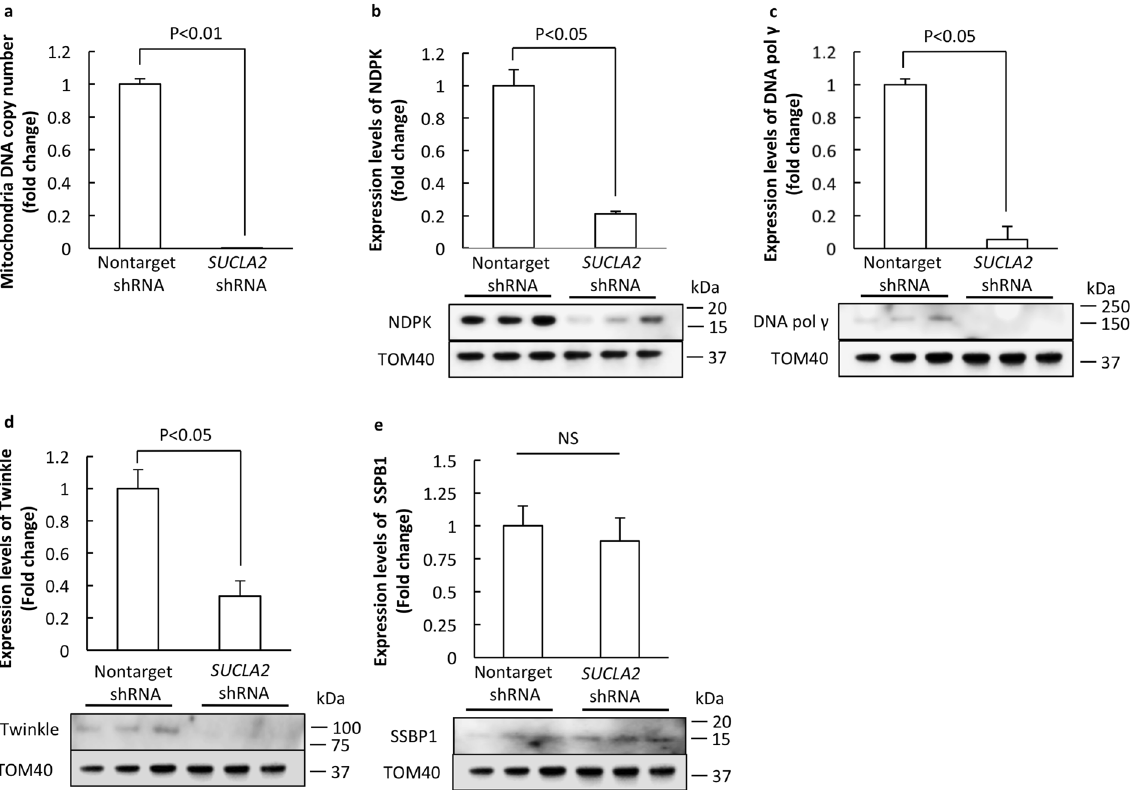
Figure 4. Loss of SCS A- β induces neuronal mtDNA depletion. ( a ) mtDNA copy number in SUCLA2- and nonTarget-shRNA-treated neurons. Nuclear DNA was used as the loading control. The expression levels of NDPK ( b ), DNA pol γ ( c ), Twinkle ( d ) and SSBP1 ( e ) in SUCLA2- and nonTarget-shRNA-treated neurons. The lower panels are representative immunoreactive bands. TOM40 was used as the loading control. The data were collected from 3 independent